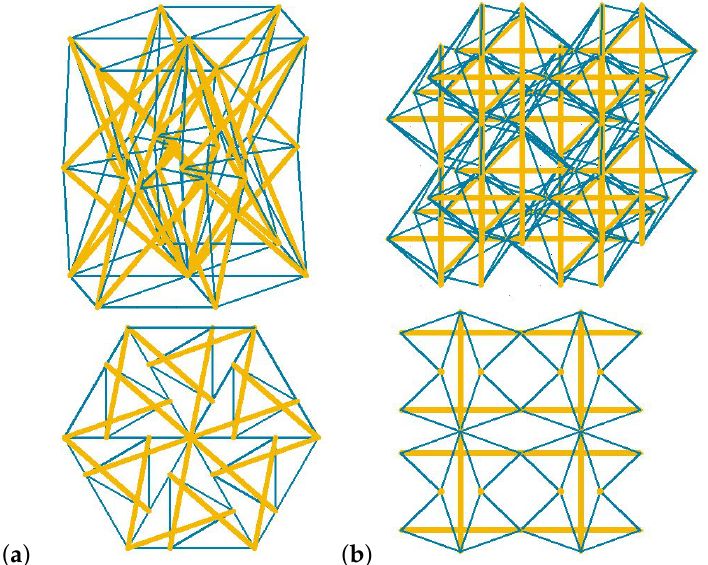
Figure 2. Material patterns: ( a ) 3-strut simplex pattern. ( b ) Expanded octahedron pattern. Struts are marked with thick yellow lines and cables with thin blue